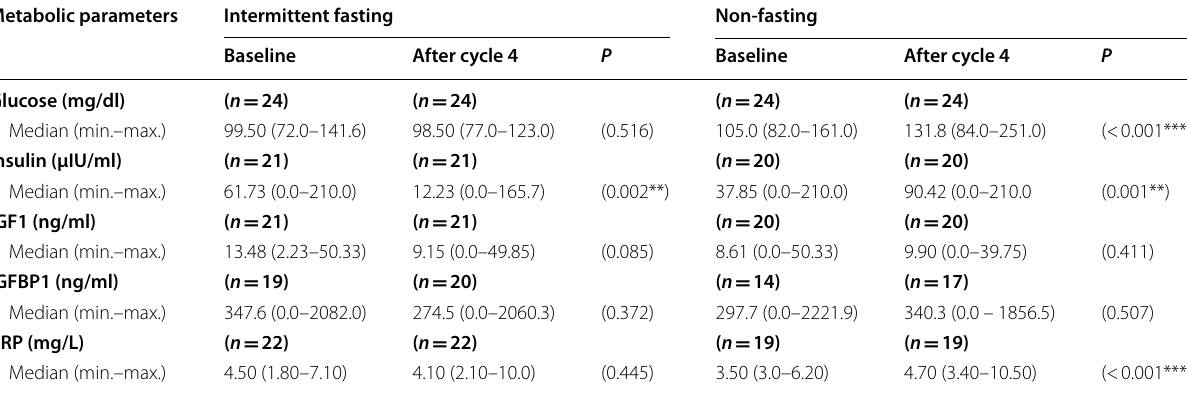
Table 5 Comparison between the two studied periods according to metabolic and inflammatory parameters in each group